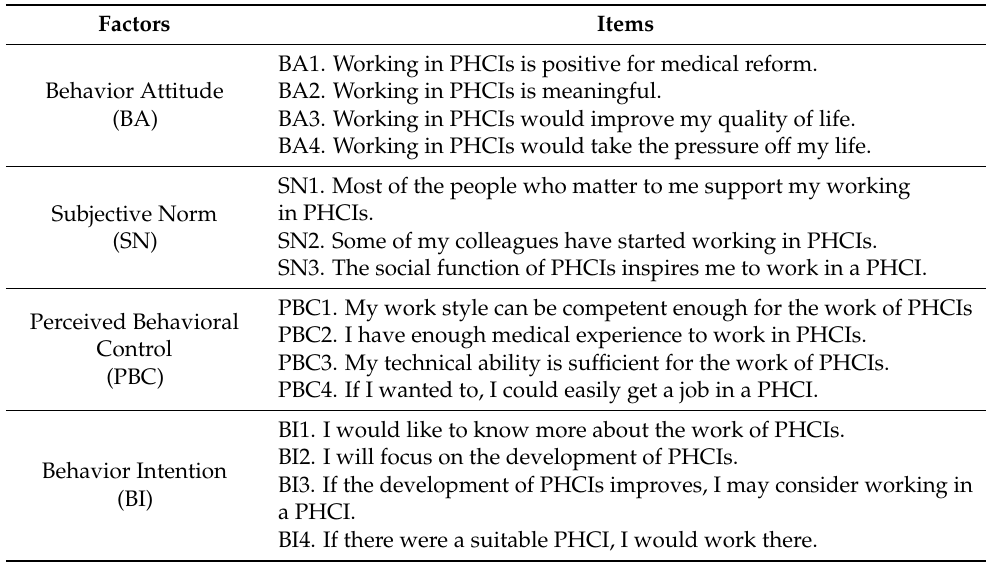
Table 1. The items of